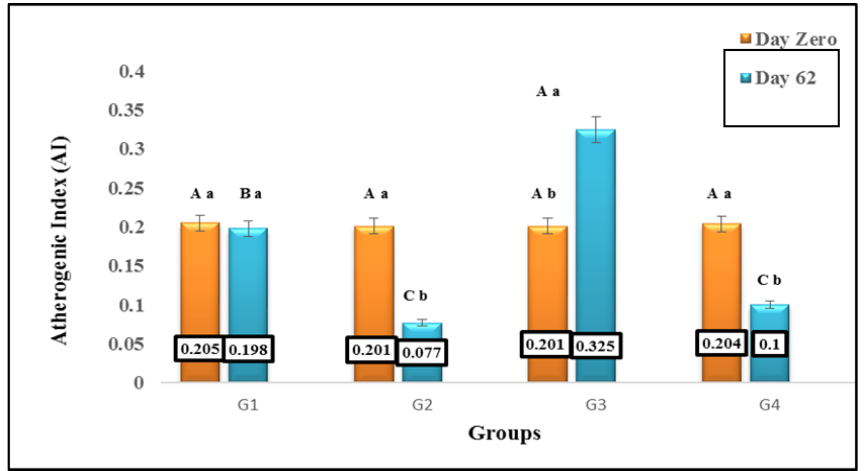
Figure 6. Effect of phosphatidylcholine, fructose and/or combination on Atherogenic Index. Mean ± SE, n = 9 in a group. G1 control groups (C), G2: (Pc), G3: (Fr), G4: (Fr + Pc). A-C Significant variations P ≤0.05 between peroids